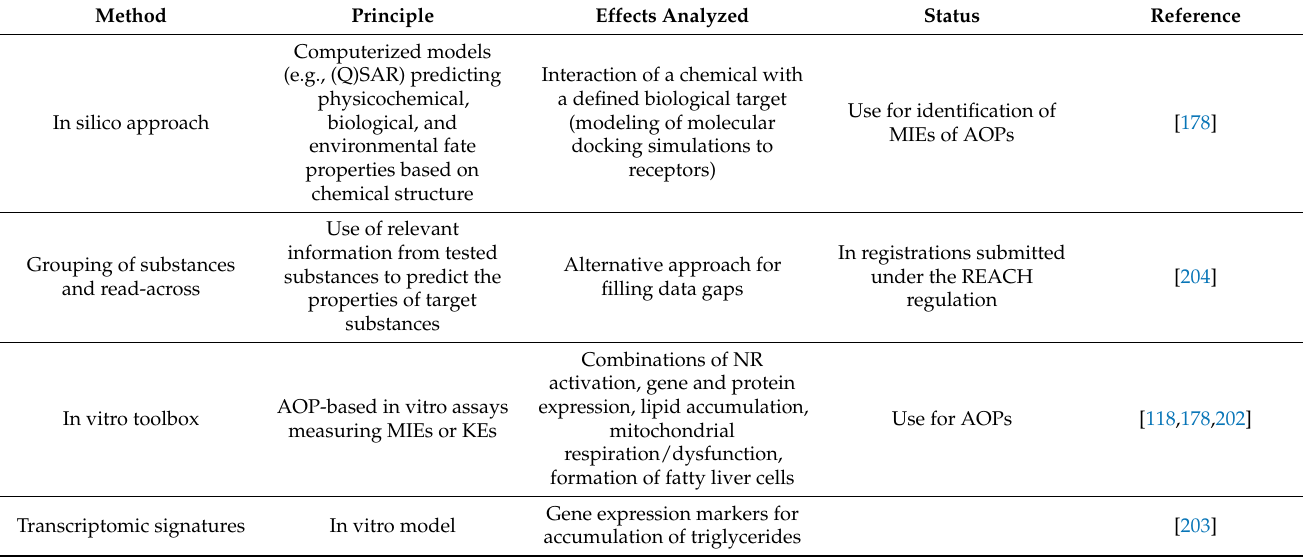
Table 4. Validated or suggested test